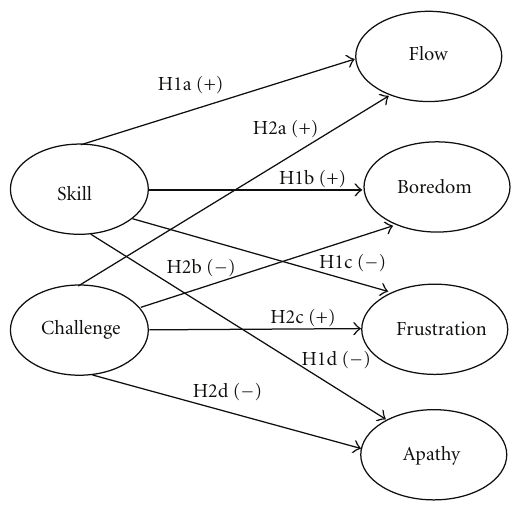
Figure 1: Theoretical